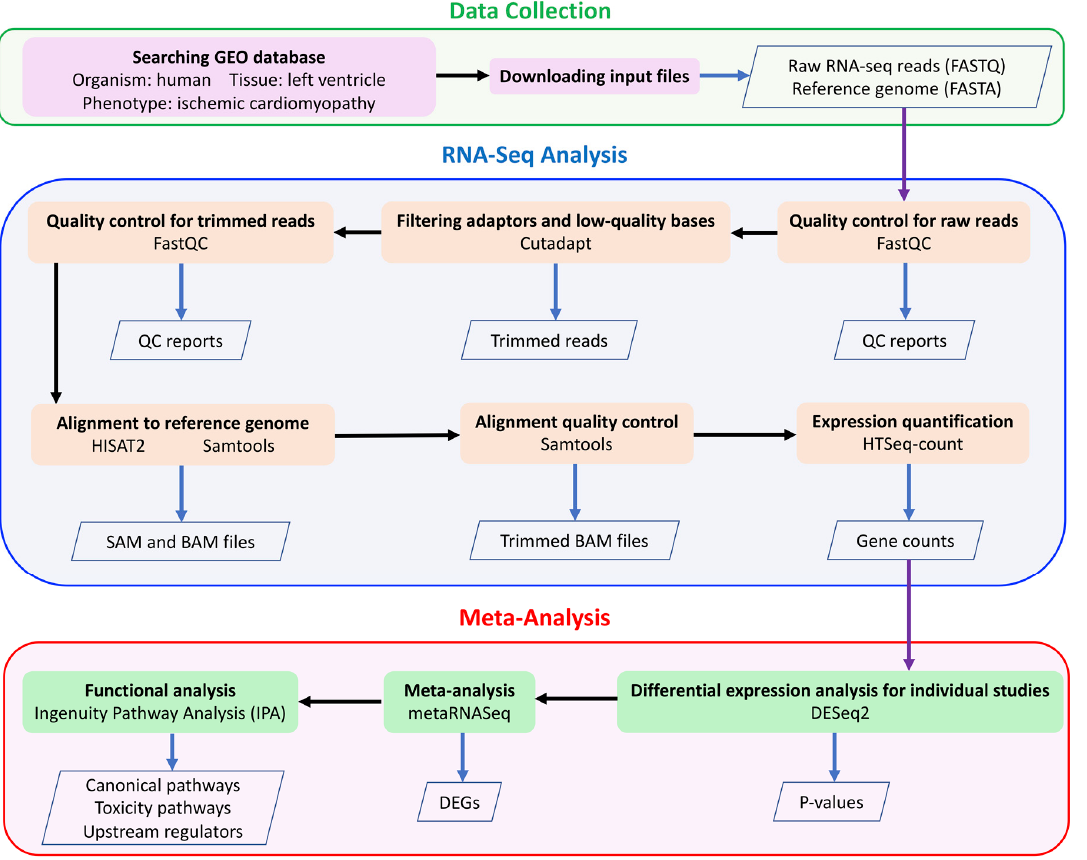
Figure 6. The meta-analysis